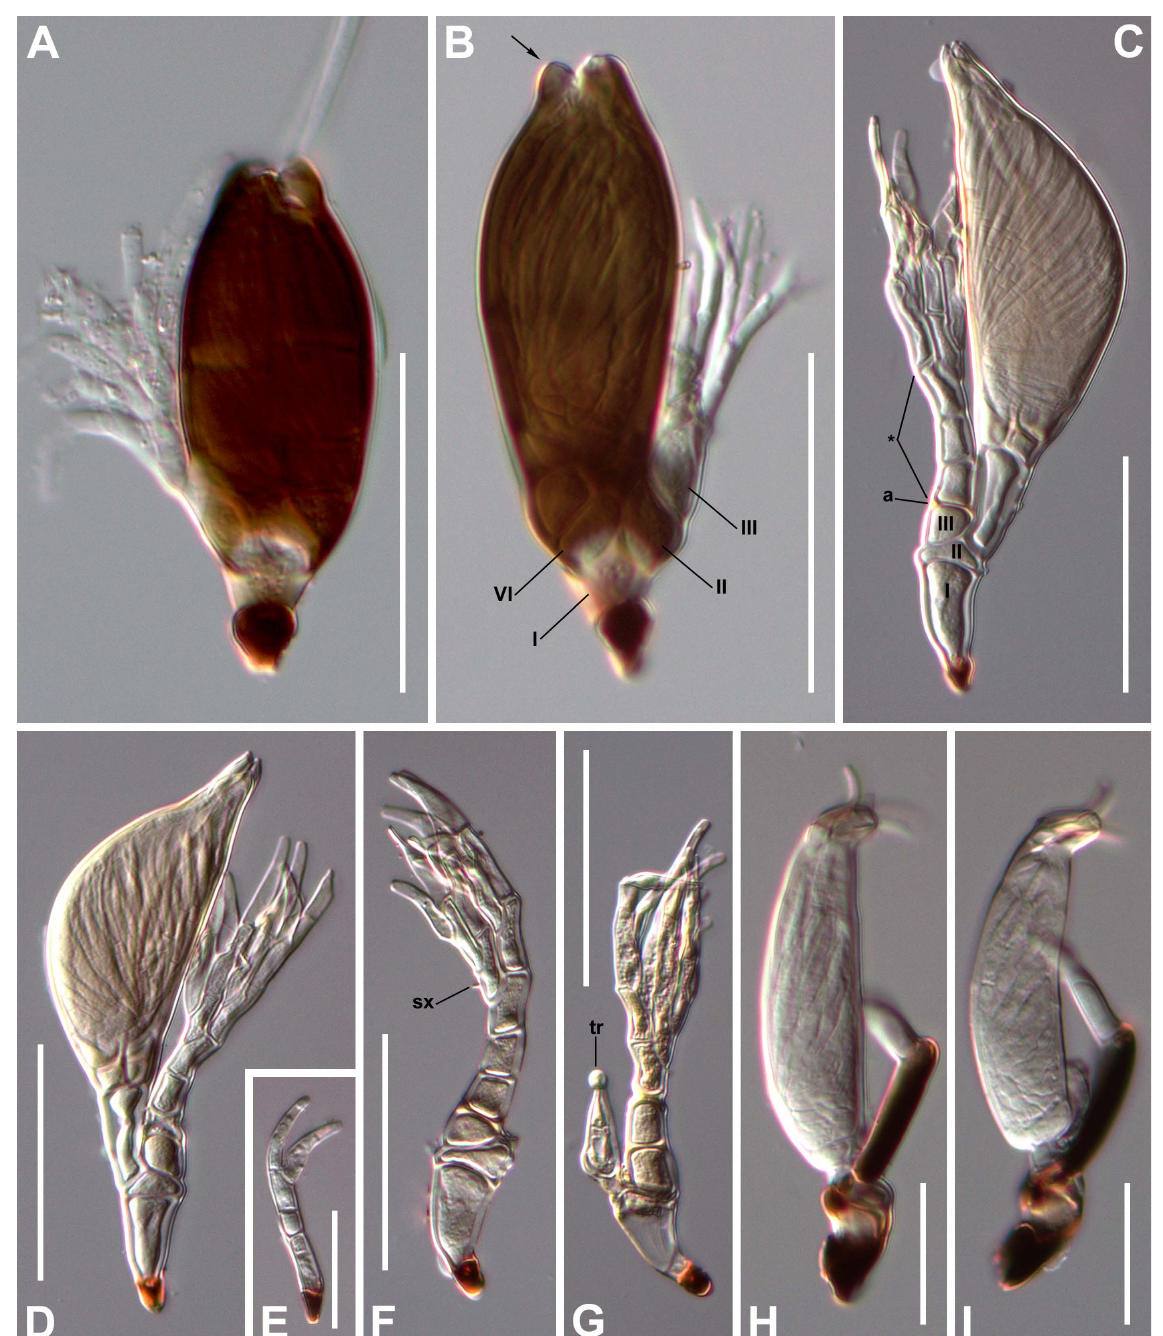
Fig. 52. A – B . Diphymyces niger (T.Majewski) I.I.Tav. Mature thalli. Some cells are labelled in B, as I, II, III and VI, as well as the stout, tooth-like prominence, on the perithecial tip (arrow). – C – G . Dipodomyces phloeocharidis T.Majewski. C . Mature thallus showing cells I, II, III, the primary septum (a), and the main axis of the primary appendage consisting of three superposed cells (*). D . Mature thallus. E . Reduced male thallus with apparently two functional antheridia. F – G . Immature thalli showing the original spore apex as a spinous process (sx) and trichogyne (tr). – H – I . Distolomyces forficulae (T.Majewski) I.I.Tav. Mature thalli. Scale bars: A–D, F–H = 50 µm; E, I = 25 µm. Photographs from slides ZMUC C-F-123826 (A), ZMUC C-F-124075 (B), ZMUC C-F-122514 (C–G), ZMUC C-F-124076